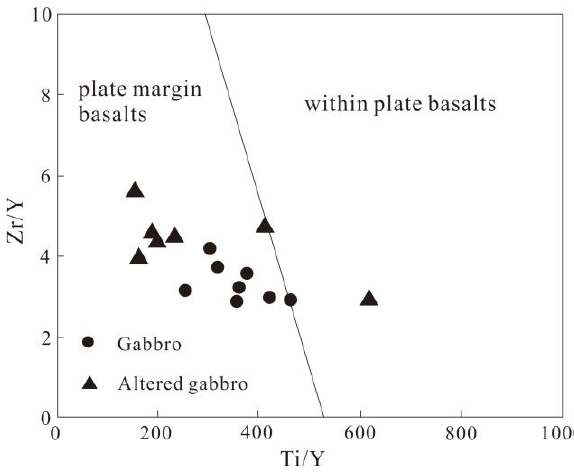
Figure 11. Gb/Yb versus Sm discrimination diagram for Ping’an gabbros.